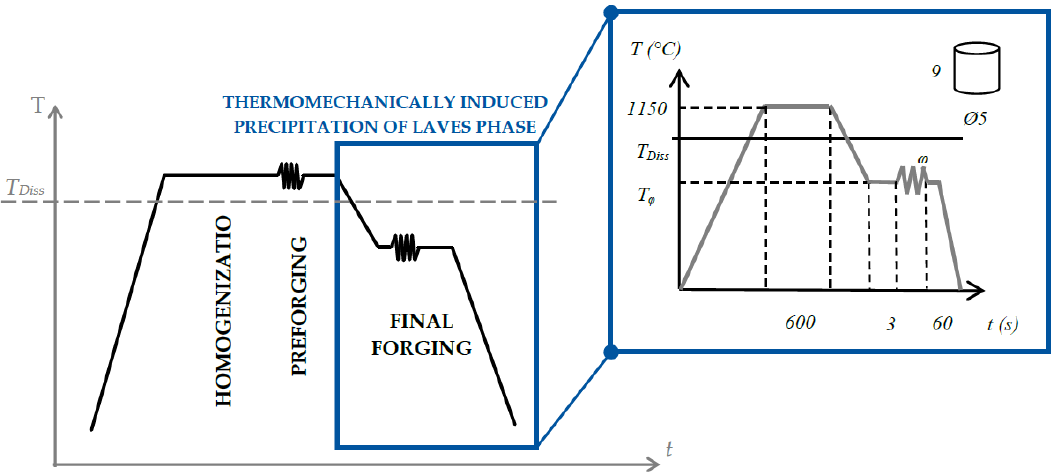
Figure 1. Thermomechanical processing chain applied in the deformation of small-trial-processing specimens for the in-depth investigation of thermomechanically induced precipitation of the strengthening Laves phase. Varying deformation temperatures T φ (800/850/900 °C) and deformation grades φ (0.25 /0.5/1) were applied. T Diss indicates the calculated Laves phase dissolution tempera- ture.